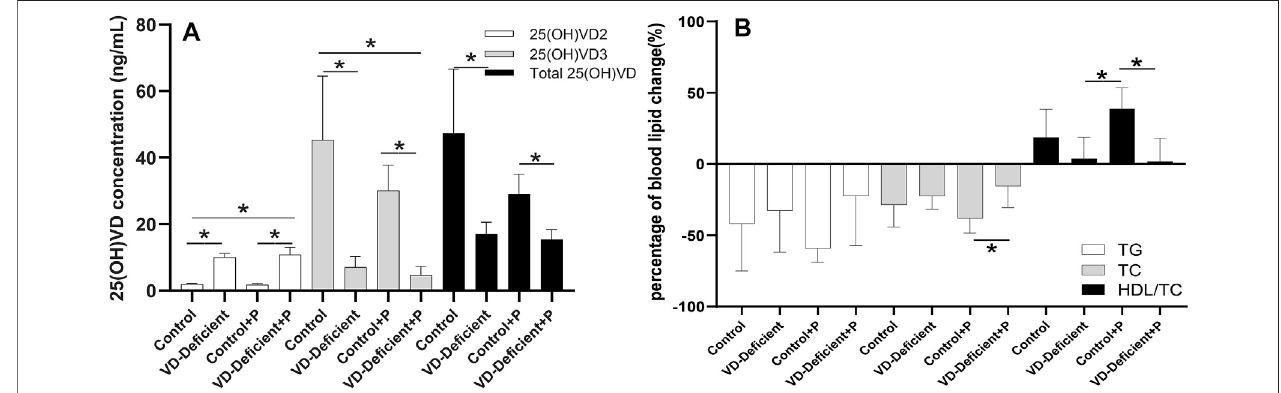
FIGURE3 | Effect of vitamin Dde fi ciency onthe pravastatin ef fi cacy inrats. (A) Final 25(OH)VD 2 , 25(OH)VD 3 and total 25(OH)VD concentration inrats fed on aVD- supplement/freehigh-fatdietwith/withoutpravastatin.25(OH)VD 3 andtotal25(OH)VDinVD-suf fi cientratswerehigherthanVD-de fi cientrats,and25(OH)VD 2 waslower ( p < 0.05). (B) Percentageofbloodlipidchange(TG,TC,andHDL)inratsfedonaVD-supplement/freehigh-fatdietwith/withoutpravastatin.Amongthefourgroups,TG and TC levels in rats fed on aVD-supplementationdiet and treated with pravastatin (Control +P) decreased the most, whereas HDL-C/TC increased the most. TG and TC levels in VD-suf fi cient rats were lower than in VD-de fi cient rats, while HDL-C/TC was higher. Control: rats fed on a VD-supplement high-fat diet ( n = 7); VD- de fi cient:ratsfedonaVD-freehigh-fatdiet( n =7);Control+P:ratsfedonaVD-supplementhigh-fatdietandadministeredpravastatinviagavagefor15 days( n =7);VD- de fi cient + P: rats fed on a VD-free high-fat diet and administered pravastatin via gavage for 15 days ( n = 9). TG: triglycerides, TC: total cholesterol, HDL-C: high-density